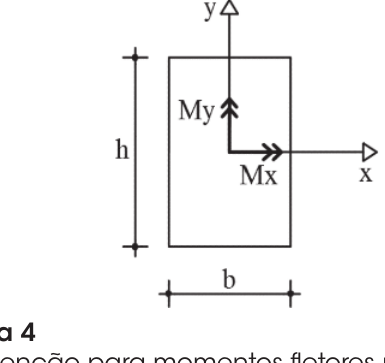
Figura 4 Convenção para momentos fletores